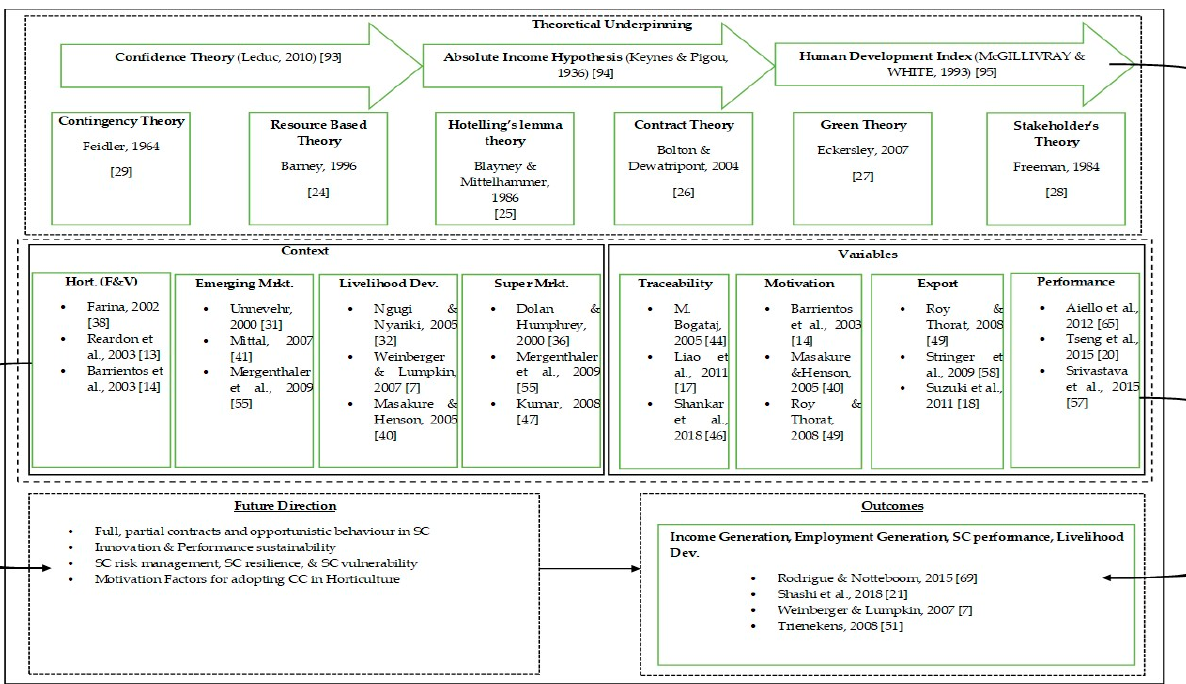
Figure 3. Context, Future Direction, and Outcomes, Source: The Authors.